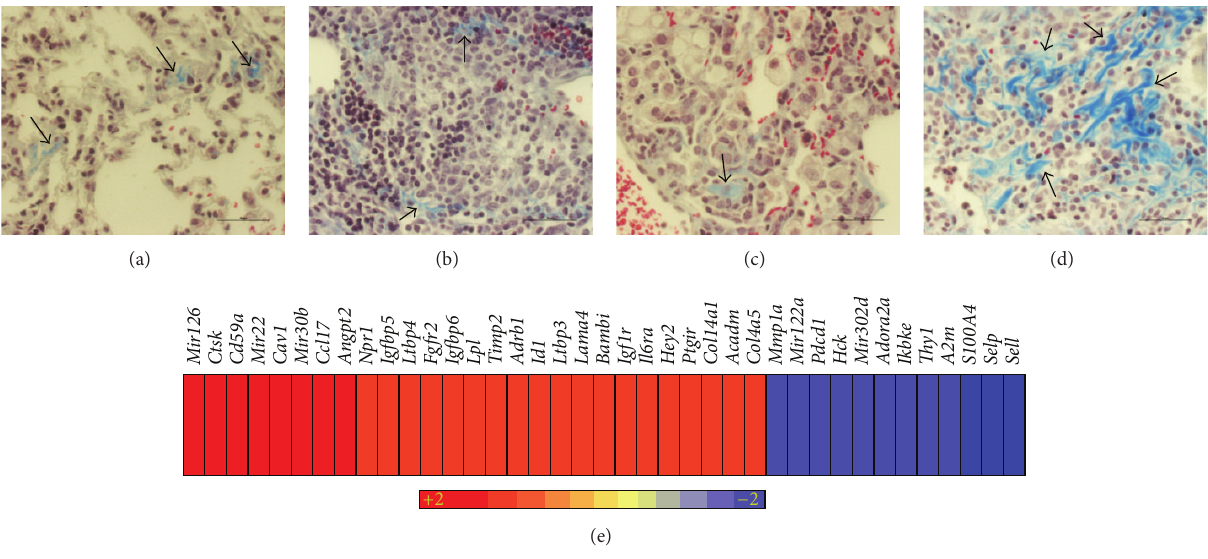
Figure 5: Fibrosis in the lungs of vaccinated and uninfected or Mtb-infected mice. ((a)-(b)) Masson’s trichrome stained lung section of BCG vaccinated (for 8 weeks) and uninfected (a) or Mtb-infected (b) mice. ((c)-(d)) Masson’s trichrome stained lung section of Δ bfrB vaccinated (for 8 weeks) and uninfected (c) or Mtb-infected (d) mice. The arrows in (a) and (c) show basal level of fibrosis (blue color). The arrows in (b) show minimal fibrosis in the BCG vaccinated and Mtb-infected mice. The arrows in (d) show extensive fibrosis in the Δ bfrB vaccinated and Mtb-infected mice. Magnification: 4x ((a) and (c)) or 40x ((b) and (d)). (e) Intensity plot of significantly differentially expressed genes involved in the fibrosis network. The values plotted are the difference in fold change in the Δ bfrB vaccinated, compared to BCG vaccinated, Mtb-infected mice lungs. Upregulated genes are in red and downregulated genes are in blue. The color scale bar ranges from +2 (red) to − 2